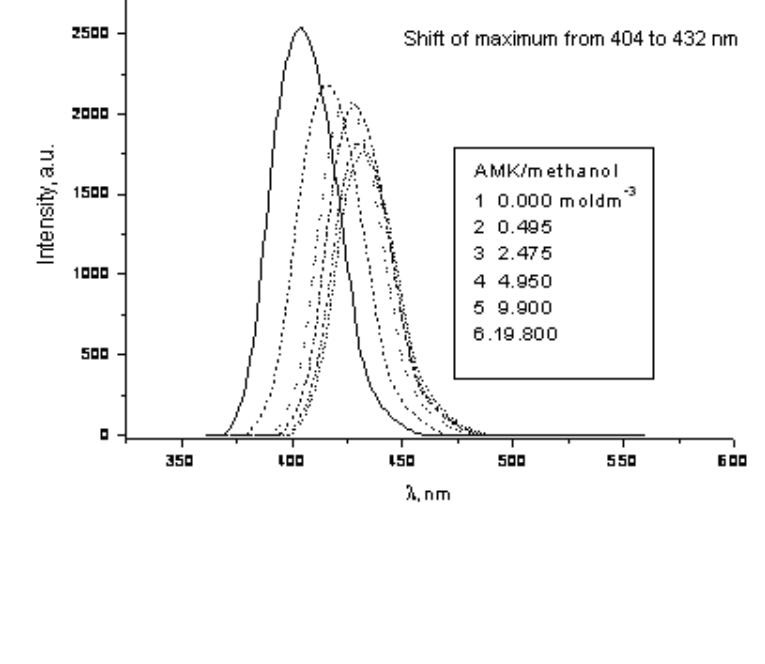
Figure 14. Quenching of fluorescence of 8 in chloroform by polar methanol (0, 0.1, 0.5, 1.0, 2.0, 4.0